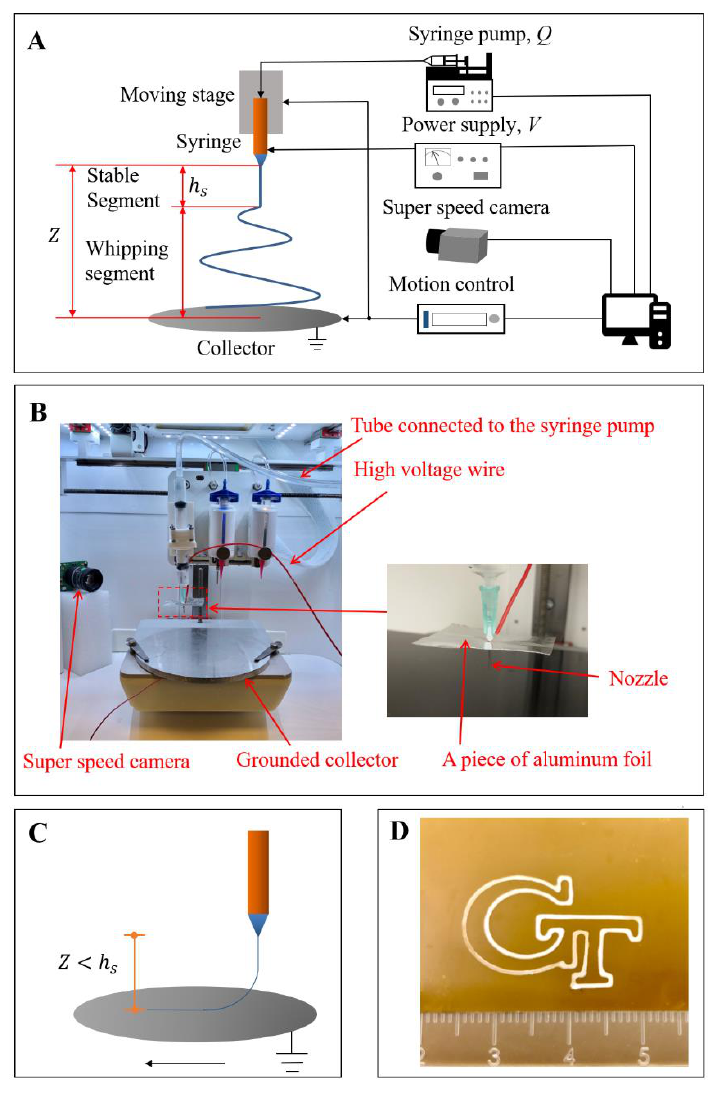
Figure 1. ( A ) Schematic of the electrospinning process. ( B ) The experimental platform (with the amplified image at the nozzle tip). ( C ) Schematic of the EHD direct-writing process. ( D ) ‘GT’ logo fabricated by EHD direct-writing. Table 1. The process parameters of EHD